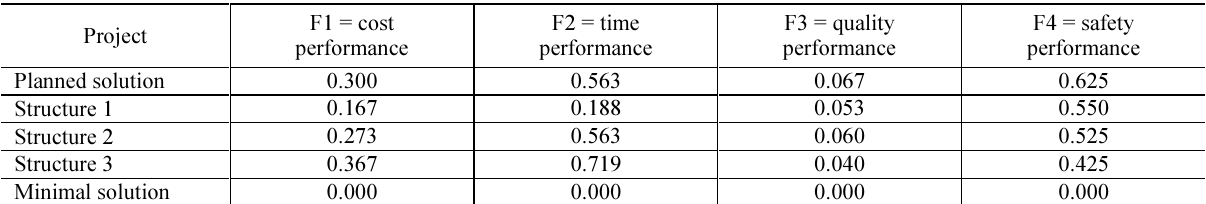
Table 5. Relativized input data